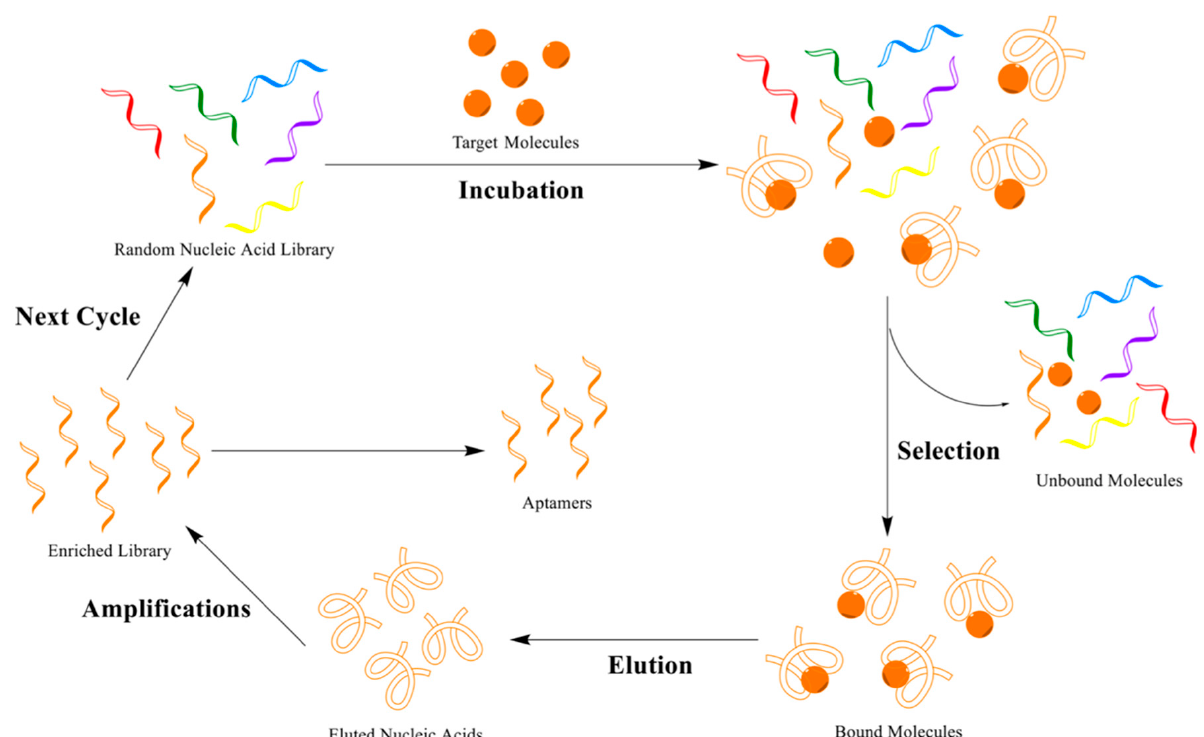
Figure 1. Process of SELEX technology. Reprinted with permission from Ref. [31] 2021, Liu.